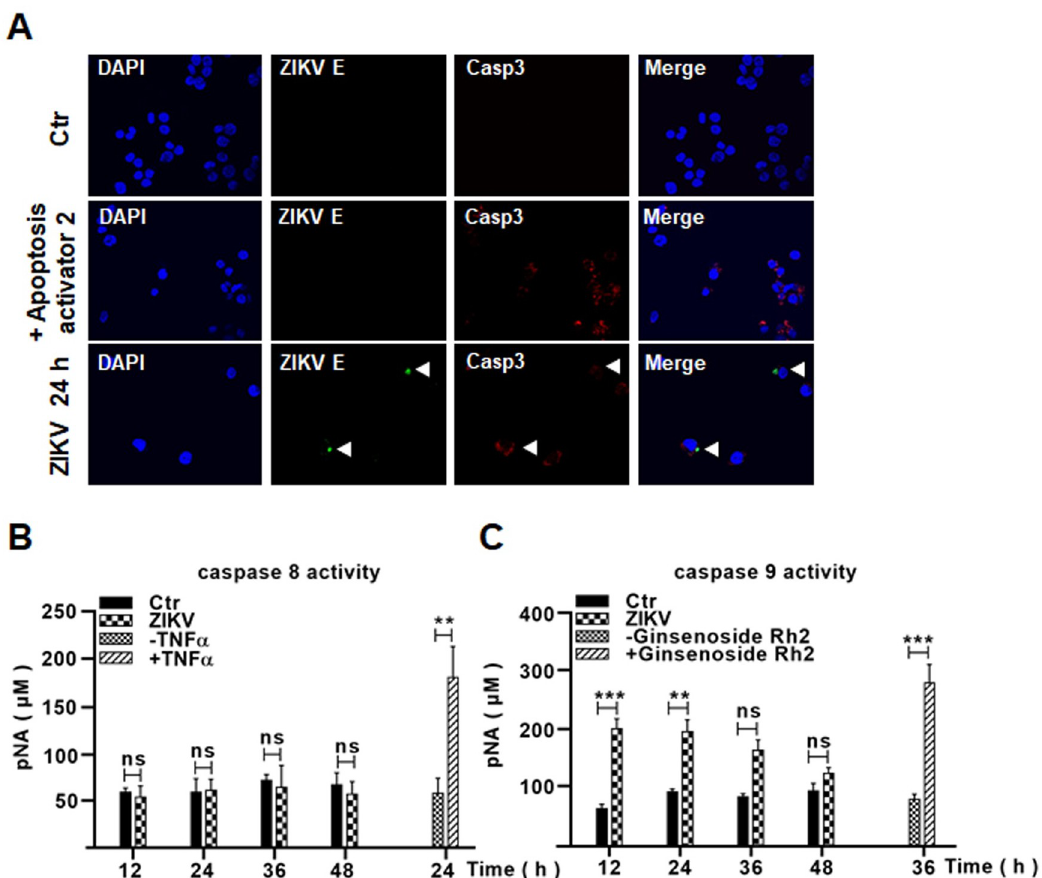
Fig 5. ZIKV infection triggered the intrinsic apoptosis in ZIKV-infected macrophages. ( A ) PMA-differentiated THP-1 macrophages, infected with 0.1 MOI of ZIKV for 24 hrs before staining with antibodies for ZIKV E and cleaved caspase-3 and subjected to confocal immunofluorescence. The infected cells positive with ZIKV E and cleaved caspase-3 were shown (arrow). The cells were treated with 10 μ M of apoptosis activator 2 for 2 hrs as a positive control for apoptosis. ( B & C ) Activation of caspase-9 in ZIKV-infected macrophages. Cell lysates were prepared from ZIKV-infected THP-1 cells for assay of caspase-8 ( B ) and caspase-9 ( C ) enzymatic activities. The cells were treated with either 20 ng/mL of TNF- α for 24 hrs or 10 μ g/mL of Ginsenoside Rh2 for 36 hrs as positive controls for activities of caspase-8 or caspase-9. The experiments were performed in triplicates and the data were shown as mean+SD, analyzed by unpaired Students t-test. �� , P < 0.01; ��� , P < 0.001. ns, no significance.